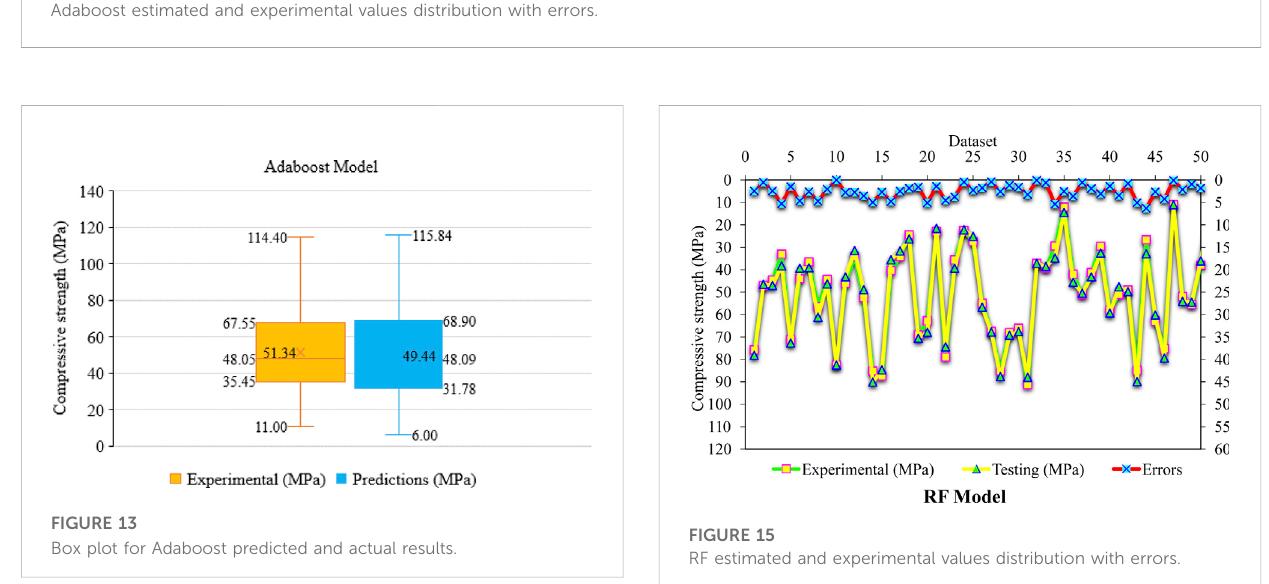
FIGURE 12 Adaboost estimated and experimental values distribution with errors.